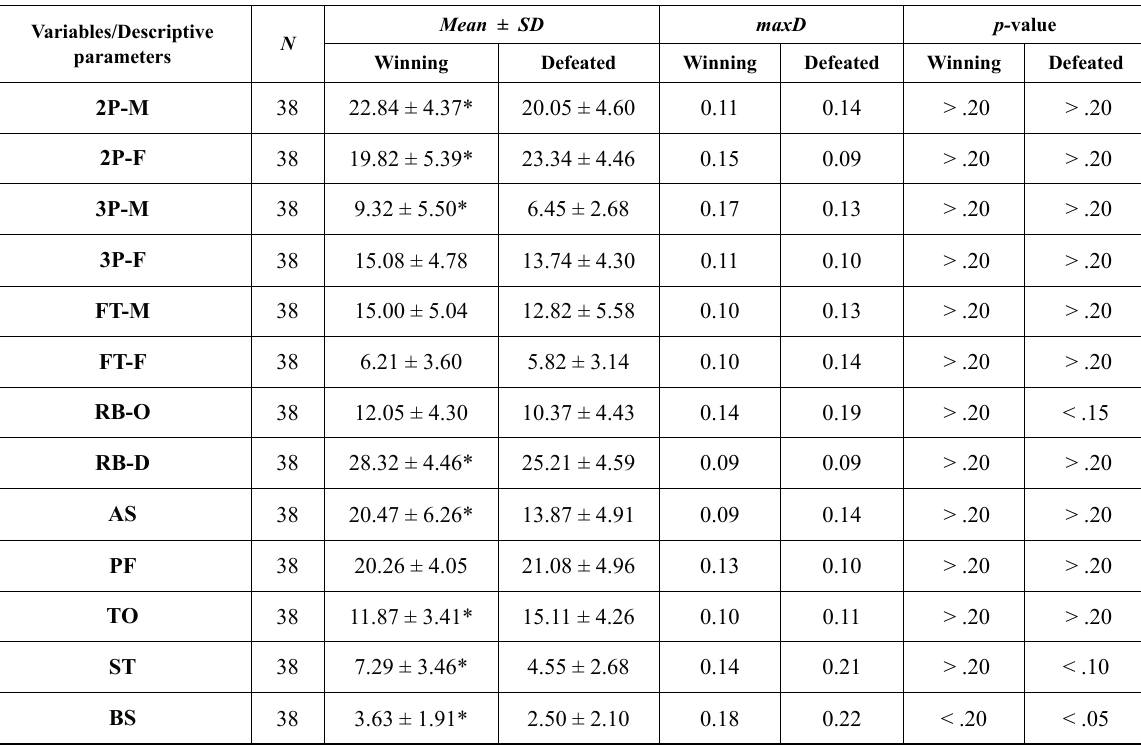
Table 2. Basic descriptive parameters of successful and unsuccessful male basketball teams Variables/Descriptive parameters